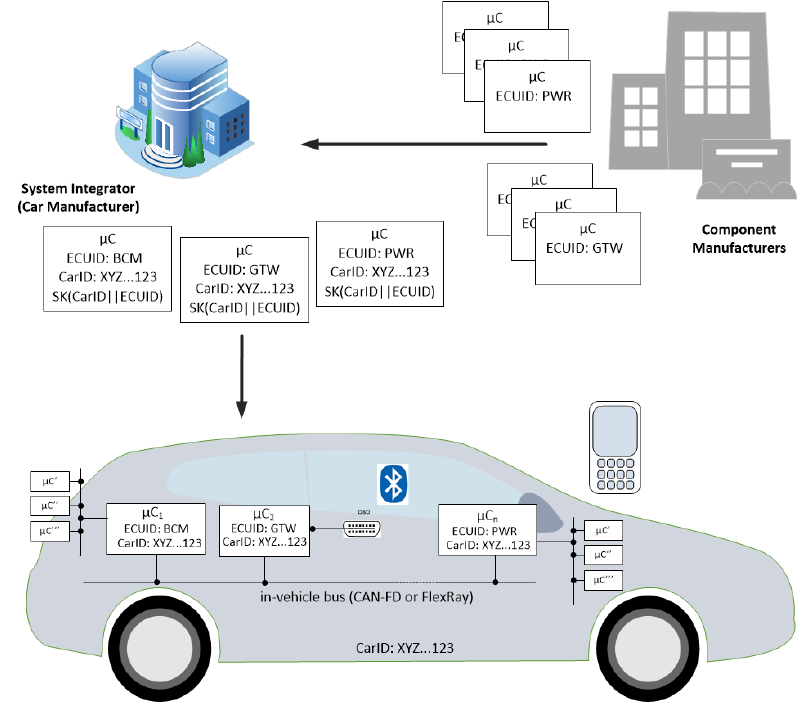
Figure 1. Addressed scenario: car setup during